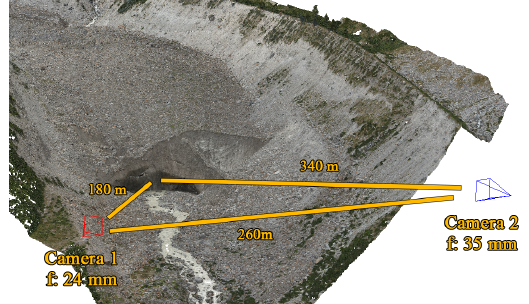
Figure 7. Configuration of cameras installed on the Belvedere glacier. The focal length of each camera is reported next to each camera.